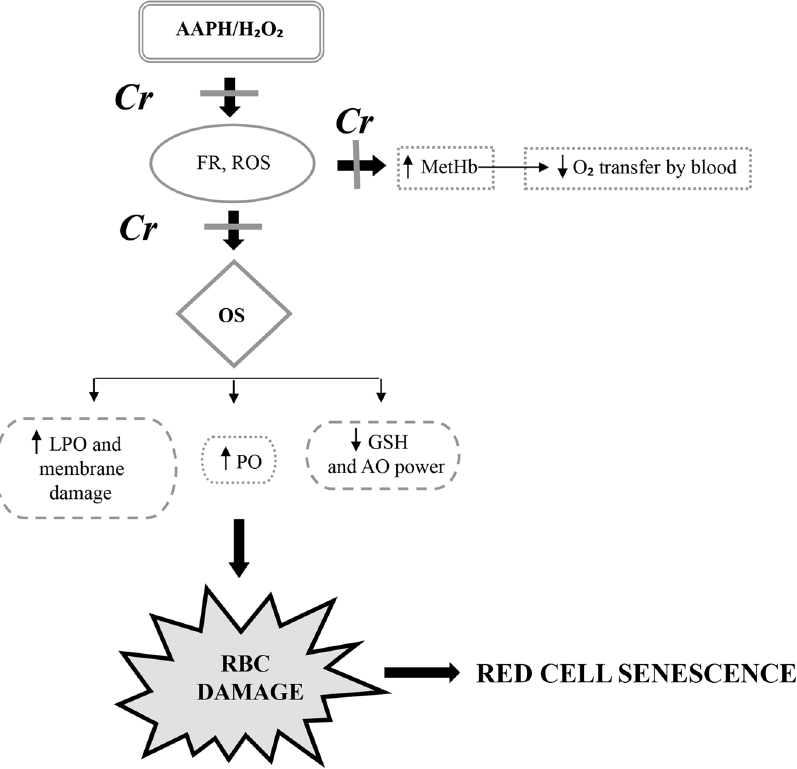
Fig 10. Schematic representation of H 2 O 2 /AAPH toxicity in human erythrocytes and protective effect of creatine. AAPH and H 2 O 2 enter the cell and, being strong oxidants, increase the generation of free radicals and reactive oxygen species leading to oxidative stress condition. This converts hemoglobin to methemoglobin and decreases the oxygen carrying capacity of erythrocytes. Glutathione levels are lowered which reduces the antioxidant power of cell and results in protein oxidation, lipid peroxidation and membrane damage. All these factors contribute to cell damage which can reduce the lifespan of erythrocytes in blood (red cell senescence) since damaged erythrocytes are removed from circulation by the spleen. Creatine protects the erythrocytes either by inhibiting the generation of free radicals and reactive oxygen species or by directly quenching them by its antioxidant property. This protects the erythrocytes from oxidative damage and can enhance their lifespan. (GSH, glutathione; MetHb, methemoglobin; ROS, reactive oxygen species; FR, free radicals; PO, protein oxidation; LPO, lipid peroxidation; OS, oxidative stress; RBC, red blood